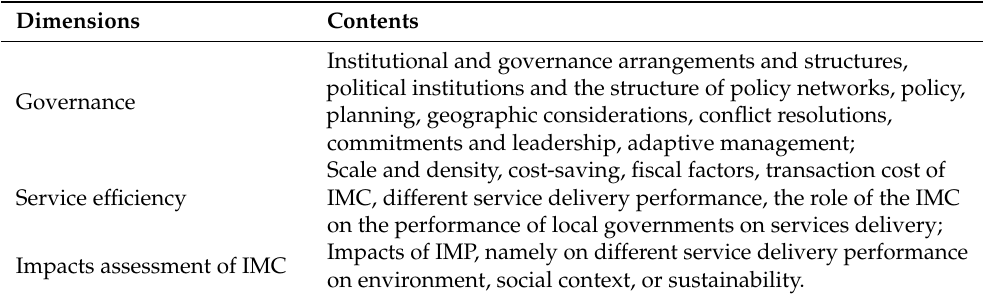
Table 2. The three dimensions and their contents.